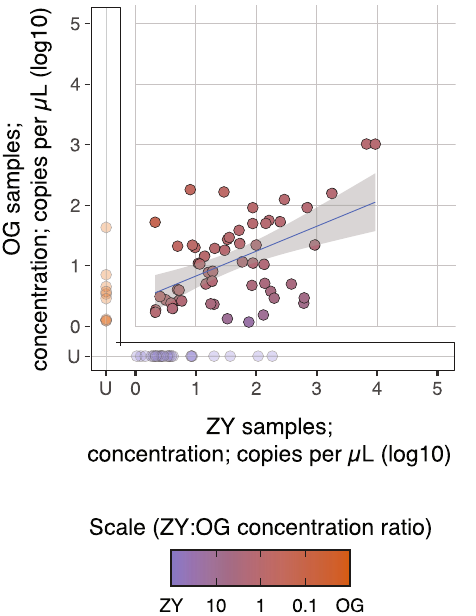
Fig. 4 Relationship between yields of SARS-CoV-2 RNA extracted from clinical samples stored in two different preservatives. Paired stool samples were collected in the OMNIgene-GUT Kit (OG) and Zymo DNA/ RNA shield buffer (ZY) preservatives from COVID-19 outpatients enrolled in a clinical trial of Peginterferon Lambda-1a. RNA from these samples had been extracted using the QIAamp Viral RNA Mini Kit (QA), assayed by RT-qPCR targeting the N1 gene and previously reported. Presented is a scatter plot of the reported concentrations of paired stool samples with concentrations derived from the ZY-preserved samples on the x -axis and from the OG- preserved samples on the y -axis. A linear regression is plotted in black and 95% con fi dence interval is shaded in gray, centered around the line of best fi t. Samples that are reported to not have ampli fi ed are delineated as U for undetermined and are not included in the linear regression analysis. This breaks down as 27 samples that were detected only in the ZY preservative, 13 that were detected only in the OG preservative, and 78 that were detected in both. The associated regression equation generated from n = 78 extractions in which both ZY and OG yielded detectable RNA is y = 0.531 + 0.381 x , R 2 = 0.203 and p = <0.001 ( F -statistic = 20.55 on df = 1 and 76, two-sided adj test). The color gradient from purple to orange represents the ratio of the concentration of RNA derived from the ZY-preserved sample (purple) to that derived from the OG-preserved sample (orange). Source data are provided as a Source data fi le.